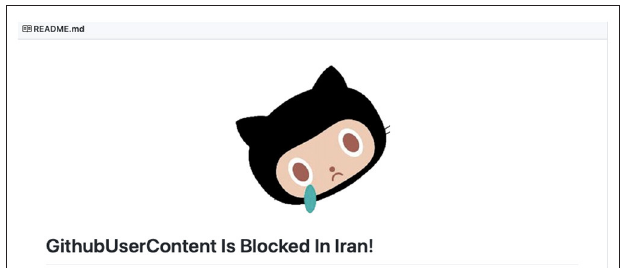
FIGURE 2 | User message returned from a GitHub access request by Iranian users in 2020. Available online at: https://github.com/pi0/github-is-blocked- in-iran (accessed April 4,